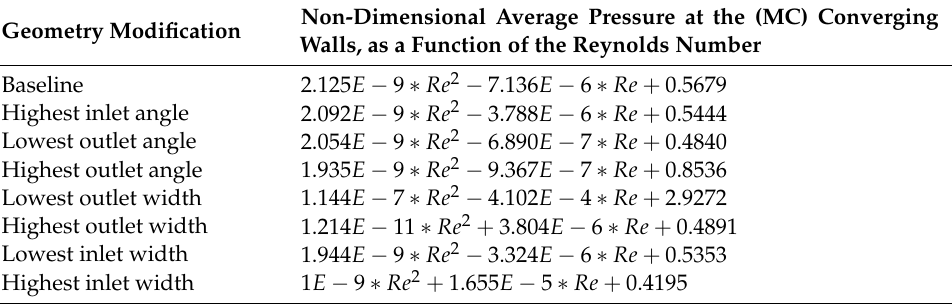
Table 3. Equations characterizing the evolution of non dimensional average stagnation pressure at the (MC) outlet converging walls, and as a function of the Reynolds number. These equations are valid in the range 8711 < Re < 32068. The coefficient of determination was ( R ) 2 = 1 for all curves presented. Non-Dimensional Average Pressure at the (MC) Converging Geometry Modification Walls, as a Function of the Reynolds